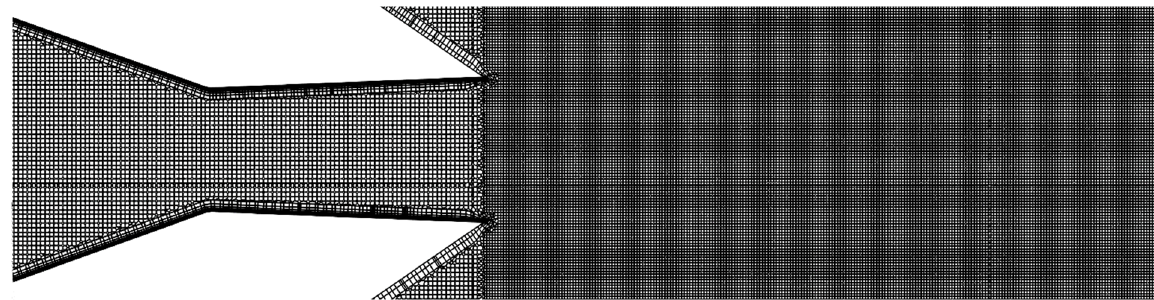
Figure 15. Contours of eddy viscosity downstream of the nozzle exit.